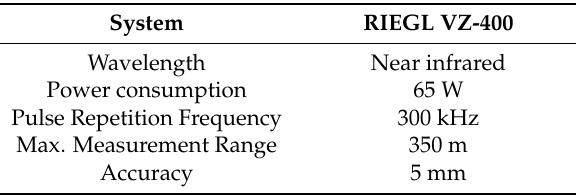
Figure 2. Configuration of the first field experiment.